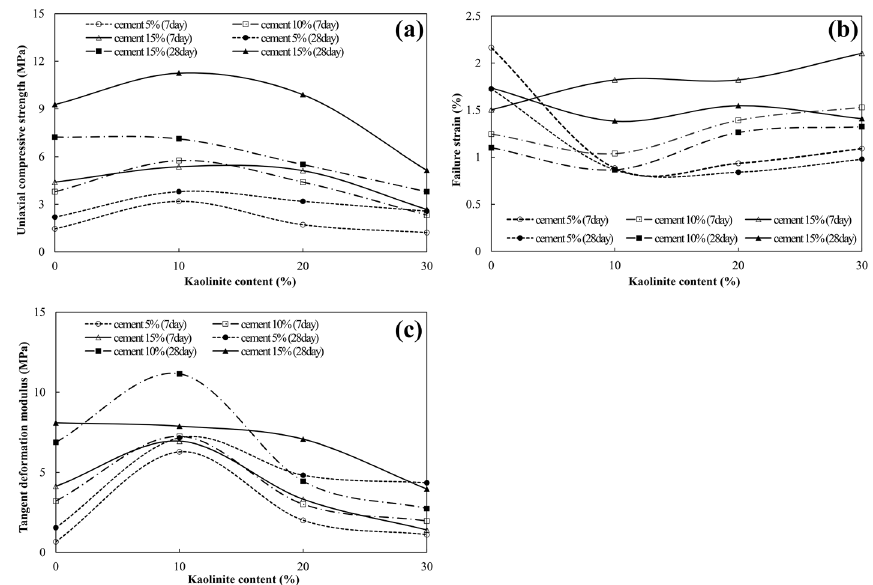
Fig. 15 The uniaxial compressive strength graph a , failure strain graph b , deformation modulus graph c versus kaolinite content graphs for CSG mixtures containing kaolinite additive and cured at both ages of 7 and 28 days